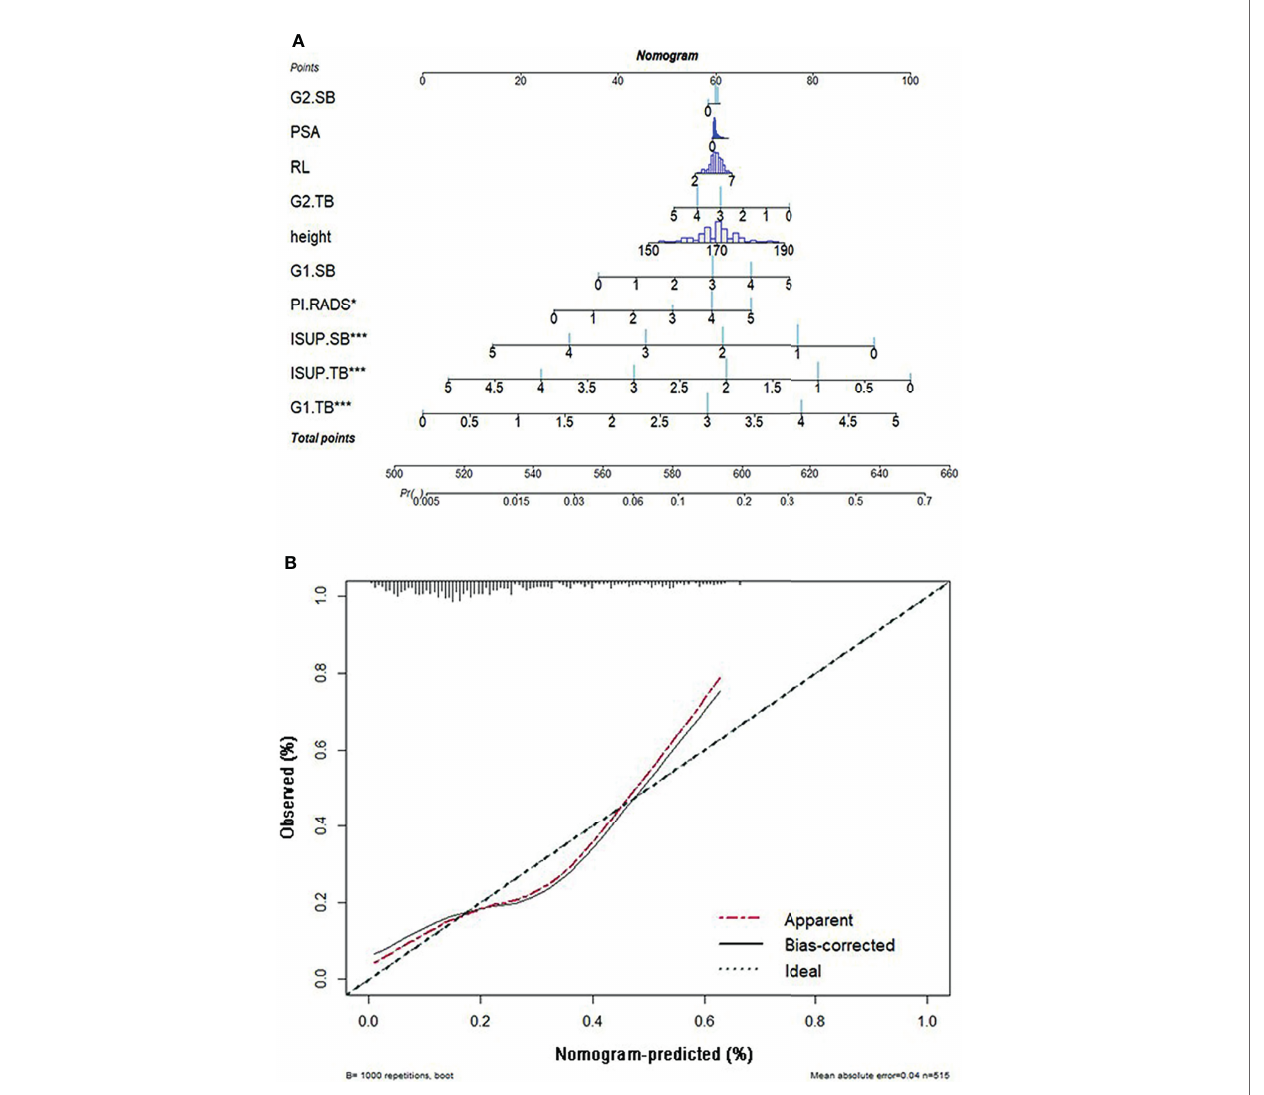
FIGURE 5 | (A) The nomogram of pathological upgrade prediction. (B) Calibration plots of observed and predicted probability of pathological upgrade. ISUP, International Society of Urological Pathology; TB, targeted biopsy; G1, primary Gleason pattern; SB, systematic biopsy; G2, secondary Gleason pattern; RL, right – left diameter; PSA, prostate-speci fi c antigen; PI-RADS, Prostate Imaging-Reporting and Data